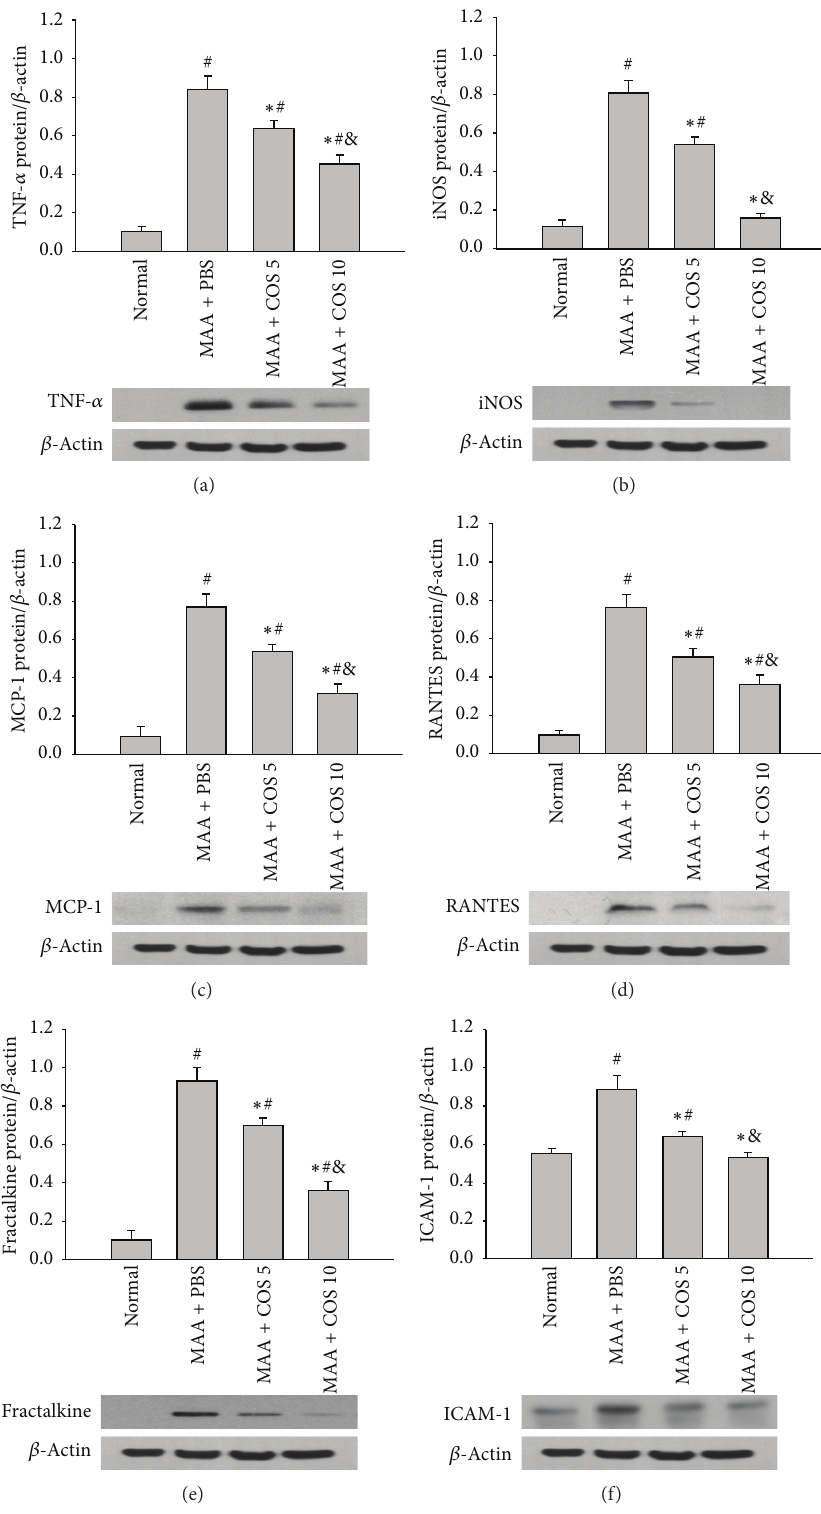
Figure 3: Evaluation of the protein expression levels of inflammatory mediators at day 14 by western blot analysis. The protein levels of (a) TNF- 𝛼 , (b) iNOS, (c) MCP-1, (d) RANTES, (e) fractalkine, and (f) ICAM-1 were significantly higher in the PBS-treated group compared with the normal rats. In the COS-treated groups, especially in the high-dose group, the levels of inflammatory mediators were significantly lower than in the PBS-treated group. The data are expressed as the mean ± SD ( ∗ 𝑃 < 0.05 compared with the PBS-treated group; # 𝑃 < 0.05 compared with the normal group; & 𝑃 < 0.05 compared with the low-dose group by Kruskal-Wallis 𝐻 test with post hoc Dunn test; 𝑛 = 8 for each